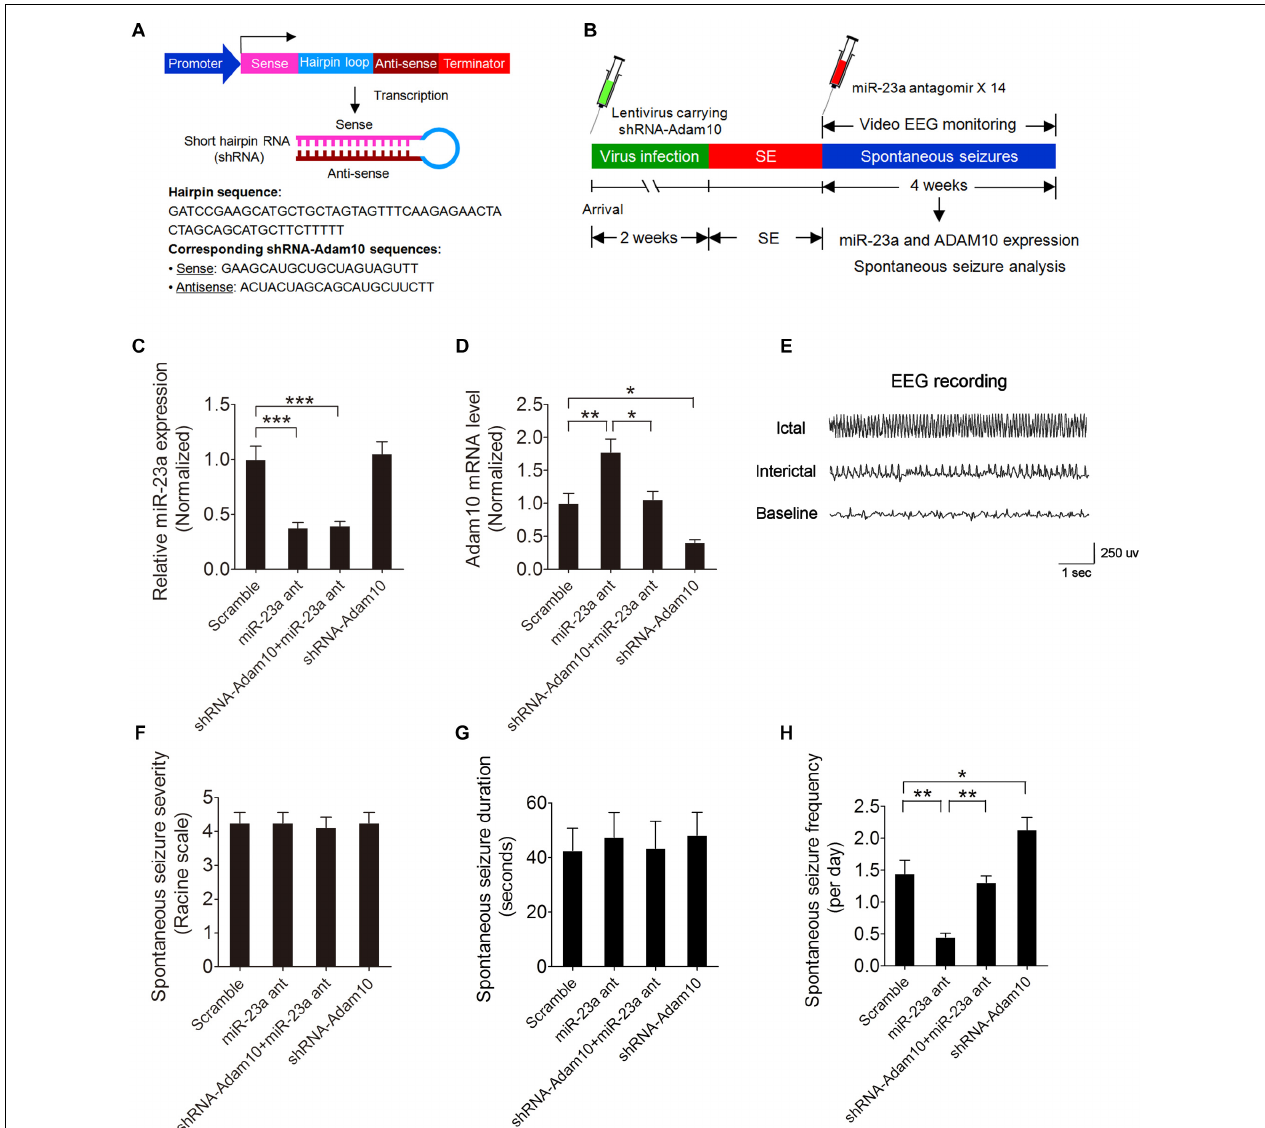
FIGURE 6 | miR-23a regulation of seizure activity by targeting ADAM10. (A) Schematic diagram showing the lentiviral shRNA-ADAM10 expression vector system. The shRNA-ADAM10 is specific to the mouse ADAM10 mRNA. (B) Schematic diagram of experimental design. Mice were injected with lentivirus carrying ADAM10-shRNA into the hippocampal CA1 regions followed by SE induction. Immediately after SE, mice were then treated with miR-23a antagomir 14 times at 48 h intervals and subjected to continuous video EEG recording for 4 weeks. After the EEG recording was finished, the mice were sacrificed for hippocampal miR-23a and ADAM10 gene expression analysis. (C,D) qRT-PCR analysis of miR-23a ( F 3 , 16 = 18.10, p < 0.001, miR-23a antagomir vs. scramble; p < 0.001, shRNA-ADAM10+miR-23a antagomir vs. scramble) and ADAM10 ( F 3 , 16 = 16.32, p = 0.006, miR-23a antagomir vs. scramble; p = 0.011, shRNA-ADAM10+miR-23a antagomir vs. miR-23a antagomir; p = 0.037, shRNA-ADAM10 vs. scramble) expression level 4 weeks after Scramble, miR-23a antagomir, shRNA-ADAM10+miR-23a antagomir and shRNA-ADAM10 treatment in the hippocampus of TLE mice ( n = 5). (E) A typical recording of the baseline, ictal and interictal EEG activity in the hippocampus. (F–H) Bar graphs showing the quantifications of average spontaneous seizure severity ( F 3 , 28 = 0.04, p = 0.99), spontaneous seizure duration ( F 3 , 16 = 0.10, p = 0.96), and spontaneous seizure frequency ( F 3 , 20 = 19.58, p = 0.001, miR-23a antagomir vs. scramble; p = 0.005, shRNA-ADAM10+miR-23a antagomir vs. miR-23a antagomir; p = 0.026, shRNA-ADAM10 vs. scramble) in scramble, miR-23a antagomir, shRNA-ADAM10+miR-23a antagomir, and shRNA-ADAM10-treated TLE mice ( n = 5–8). Values are mean ± SEM. ∗ p < 0.05, ∗∗ p < 0.01, ∗∗∗ p < 0.001, one-way